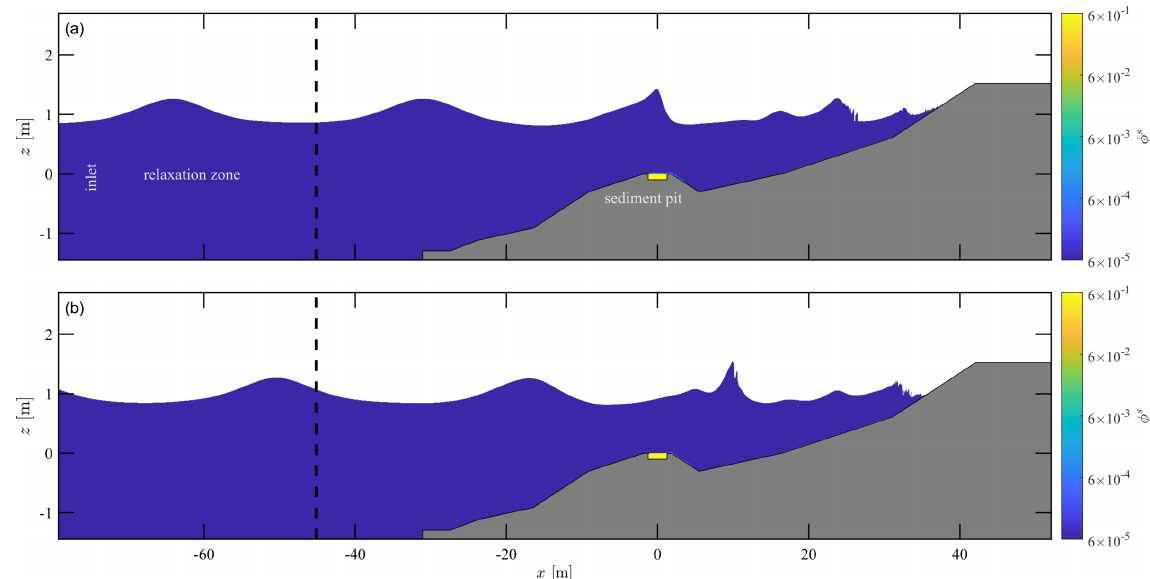
Figure 1. The x – z plane snapshots of numerical flume at ( a ) t = 59 s and ( b ) t = 61.9 s, where different colors represent air (white), water (blue), and sediment (yellow to blue) phases in S1T7H40. Vertical black dashed lines denote the boundary of the inlet relaxation